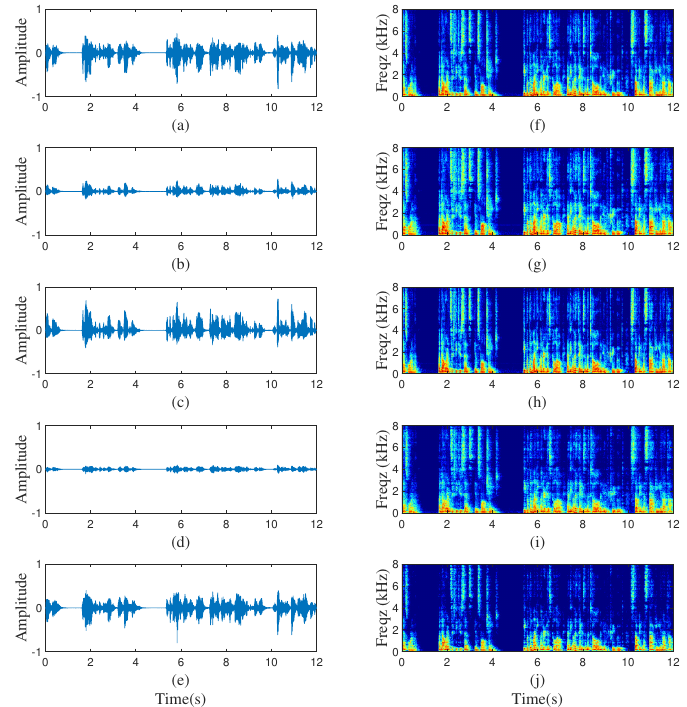
Figure 1. Waveforms and Spectrograms of B-format and echo signals. ( a , f ) B-format W-channel signal, ( b , g ) B-format X-channel signal, ( c , h ) B-format Y-channel signal, ( d , i ) B-format Z-channel signal, ( e , j ) echo